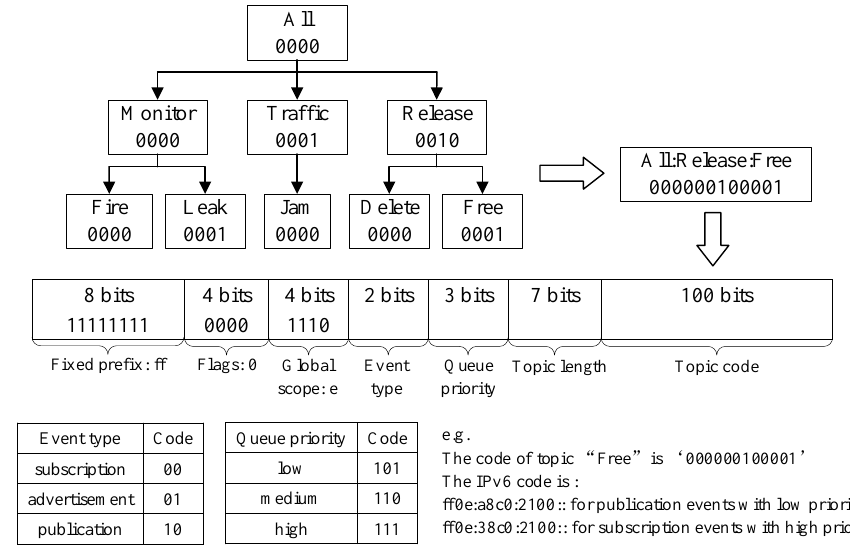
Figure 2. Topic encoding.